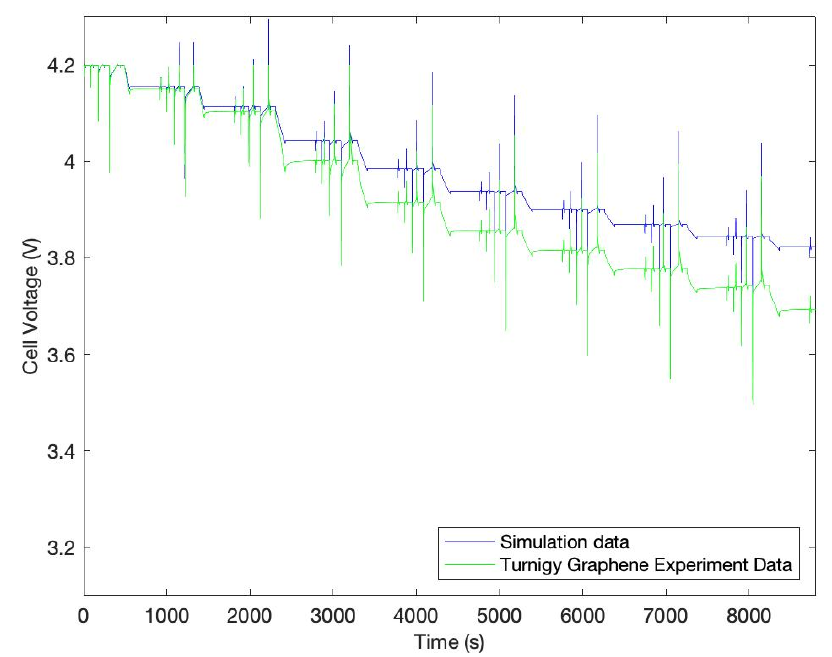
Figure 12. The cell voltage for the proposed model and the experimental Turnigy graphene battery dataset over time.